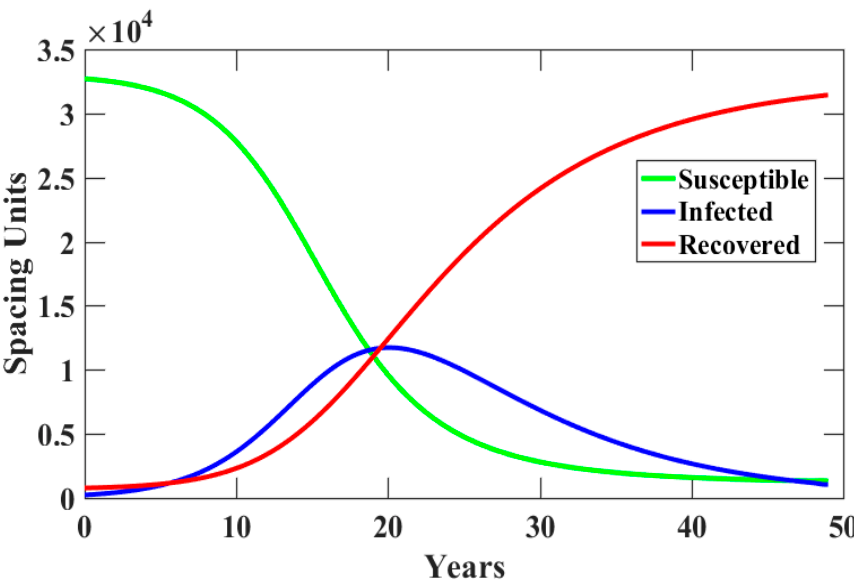
Figure 4. The dynamics of susceptible, infected, and recovered spacing units for 50 years starting from 2015.